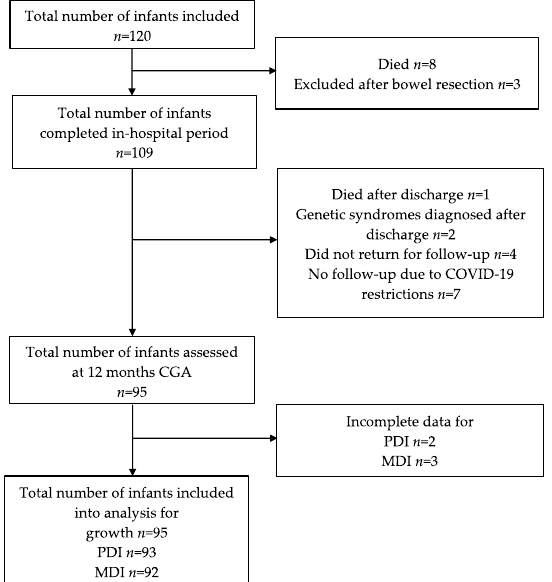
Figure 1. Follow-up chart of study participants. Figure 1. Follow ‐ up chart of study participants.